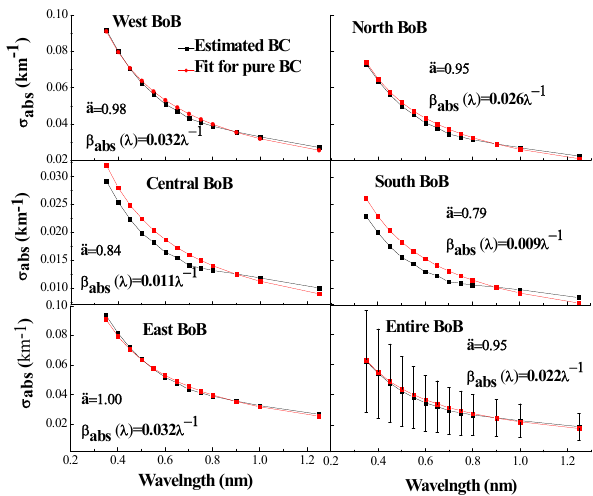
Fig. 16. Wavelength dependence of the absorption coefficient for estimated BC (OPAC) and that for pure BC assuming an absorption wavelength exponent